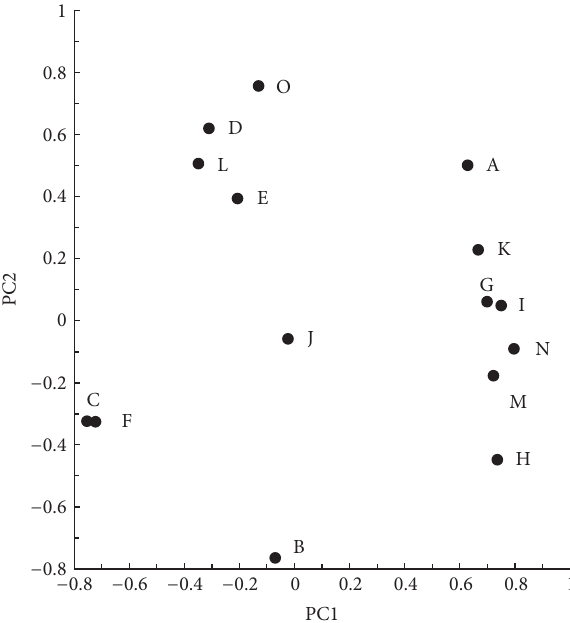
Figure1:Theloadingplotoftermoffriedfrittersin1and2principal components (PC1 and